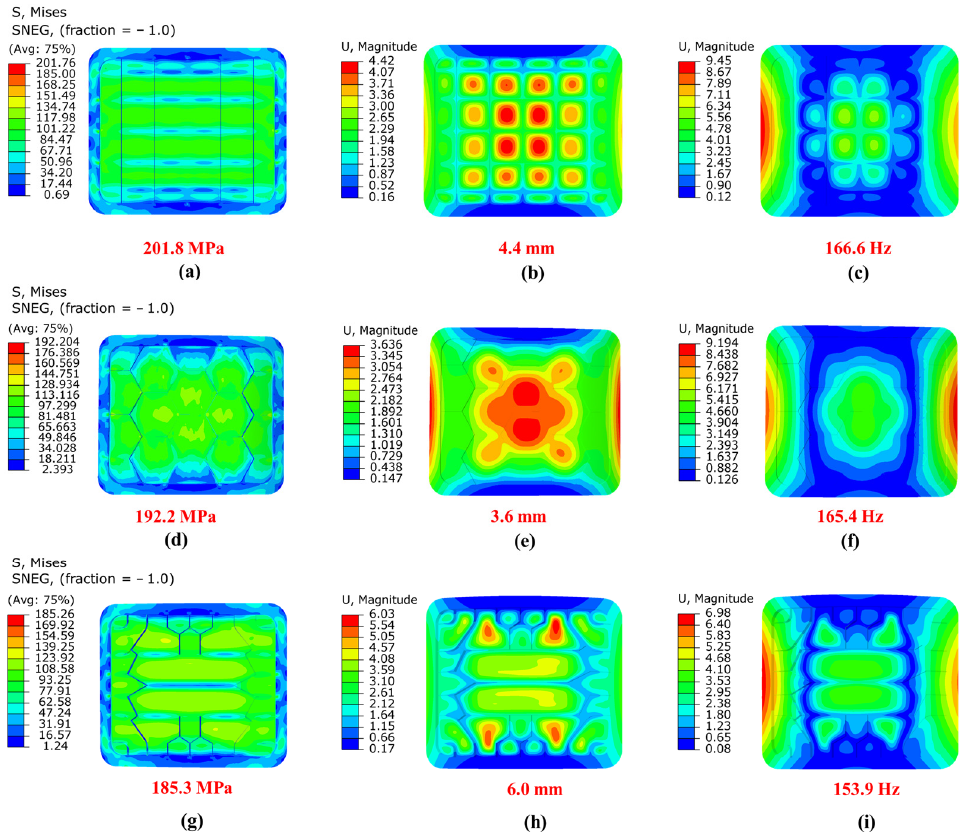
Figure 11. Comparison of the finite element analysis results between initial and optimal design of the cabin door. (a) Mises stress field of the cabin door in orthogrid design. (b) Displacement field of the cabin door in orthogrid design. (c) First order modal shape of the cabin door in orthogrid design. (d) Mises stress field of the cabin door in honeycomb design. (e) Displacement field of the cabin door in honeycomb design. (f) First order modal shape of the cabin door in honeycomb design. (g) Mises stress field of the cabin door in optimal design. (h) Displacement field of the cabin door in optimal design. (i) First order modal shape of the cabin door in optimal design.